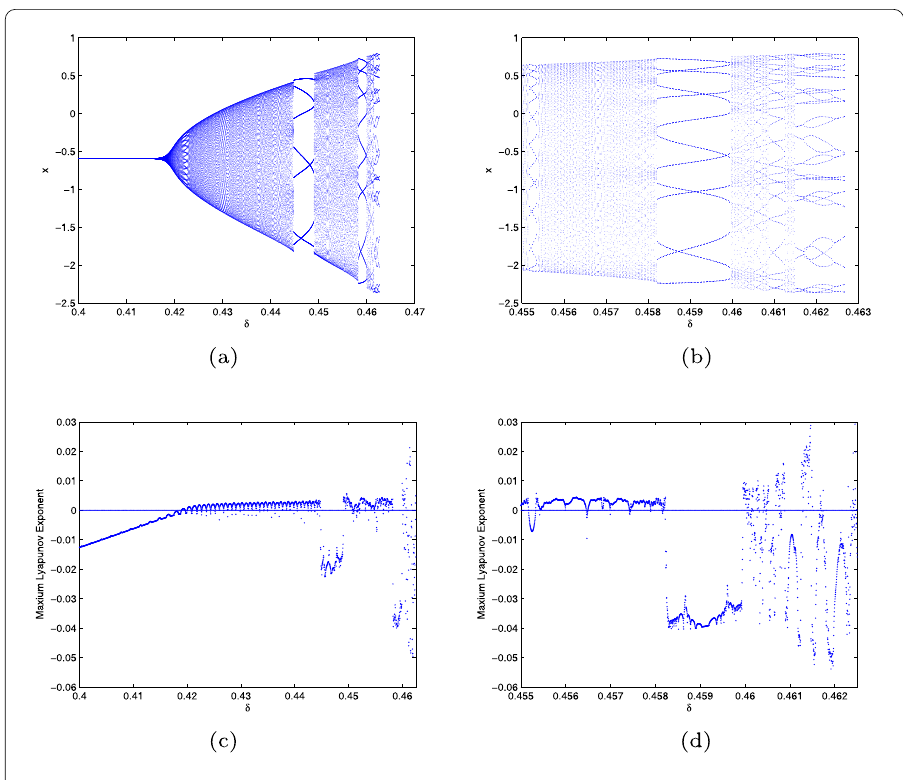
Figure 4 ( a ) Bifurcation diagram of map (3) in ( δ , x ) plane for a = 2, b = 2, c = 1, d = 5.71441. The initial value is (–0.8,–1). ( b ) Local amplification corresponding to ( a ) for δ ∈ [0.455,0.463]. ( c ) Maximum Lyapunov exponents corresponding to ( a ). ( d ) Local amplification corresponding to ( c